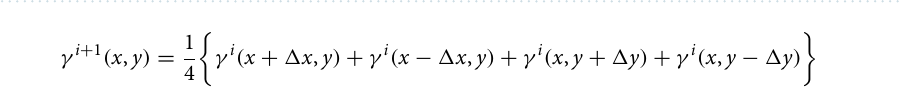
Figure 10. Color-coded examples of the estimated tortuosity for the ONL layer for ( a ) a normal and ( b ) a DR